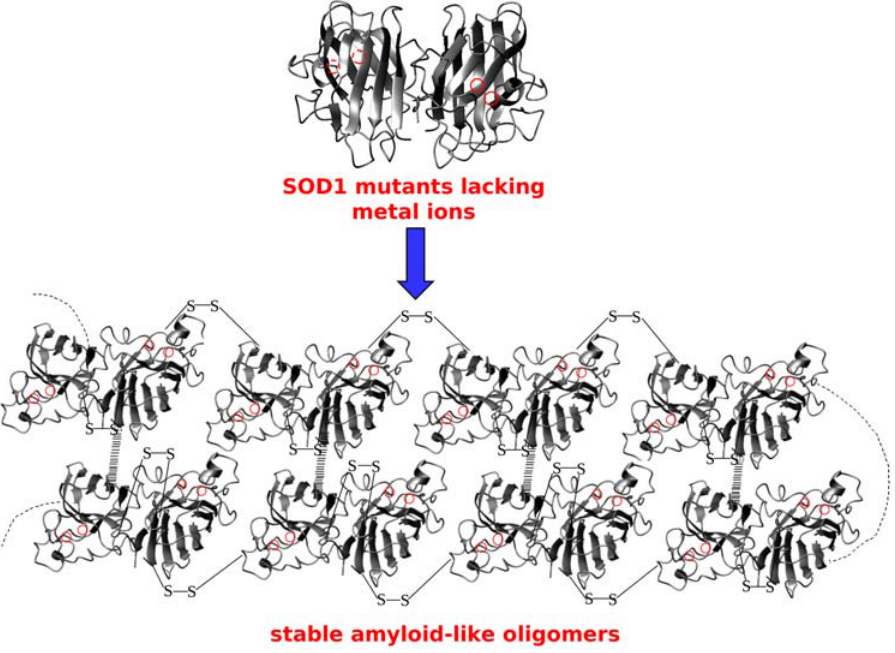
Figure 6. Mutants SOD1 aggregation. Formation of soluble oligomers occuring when apo WT SOD1 protein is kept close to physiological conditions for an extended period of time. In the absence of metal ions, SOD1 proteins form abnormal disulfide cross-links though the two free cysteines (Cys 6 and Cys 111) and noncovalent associations with other SOD1 monomers or dimers.